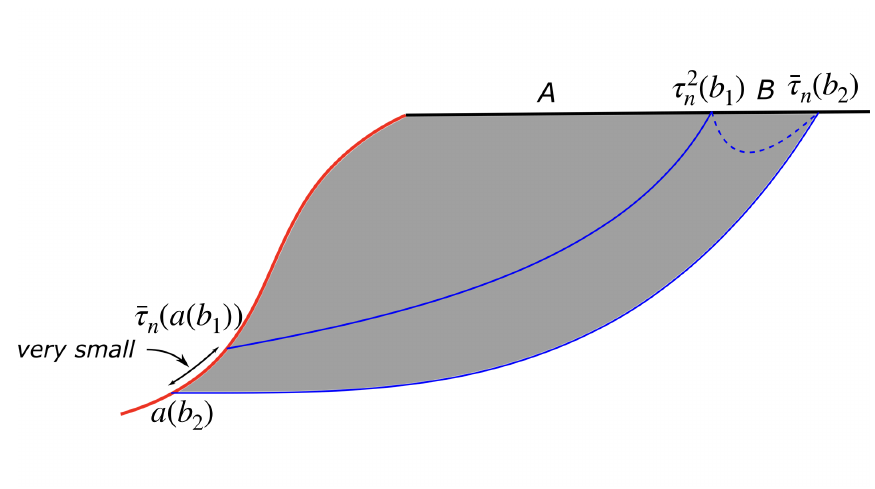
Figure 15: Schematic of the island proposal-II for the entanglement negativity of the mixed state of the adjacent intervals in phase-II. Figure modified from [ 68 ] E ( A : B ) through the generalized Renyi reflected